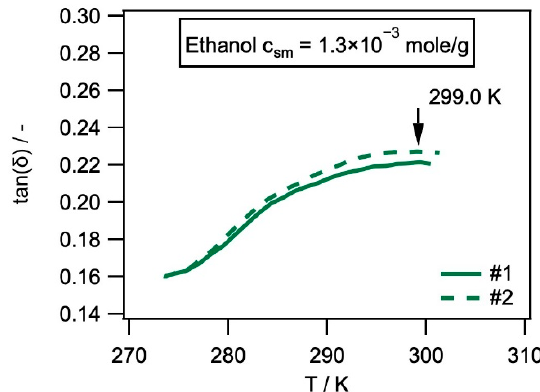
Figure 5. tan( δ ) as a function of temperature (rate of temperature ramp: 2 K/min, frequency: 10 Hz, imposed strain amplitude: 0.1%, end load: 1 N) from two experiments performed for SMP-E with an ethanol concentration of 1.3 × 10 − 3 mol/g. The arrow indicates the position of T SWITCH (identical in the two experiments shown).